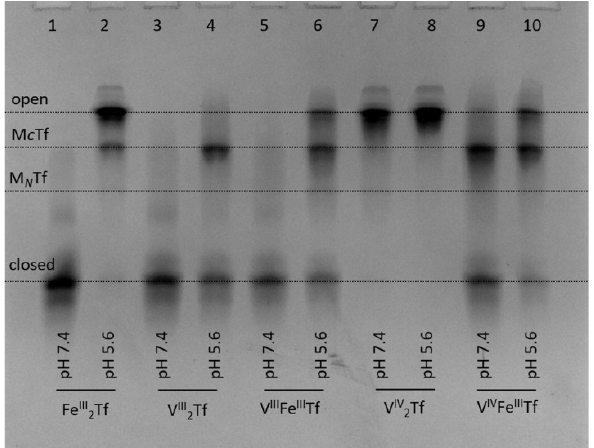
Figure 5. Urea-PAGE of the purified samples of V III2 Tf, V III FeTf, V IV2 Tf and V IV FeTf (see Materials and Methods for details) that reacted under the conditions mimicking the extracellular (20 mM HEPES, 25 mM NaHCO 3 , 140 mM NaCl, pH 7.4) and endosomal (100 mM MES, 300 mM KCl, 0.10 mM citrate, 1.0 mM ascorbate, pH 5.6) stages of the Tf cycle [3] for 5 min at 295 K. Initial Tf concentration in the reaction mixtures was 30 μM, and samples were diluted 6-fold with corresponding buffers before loading into the gel. Four main Tf conformations (Figure 1) are marked (M C Tf and M N Tf contain one metal ion bound to C -lobes or N -lobes, respectively).